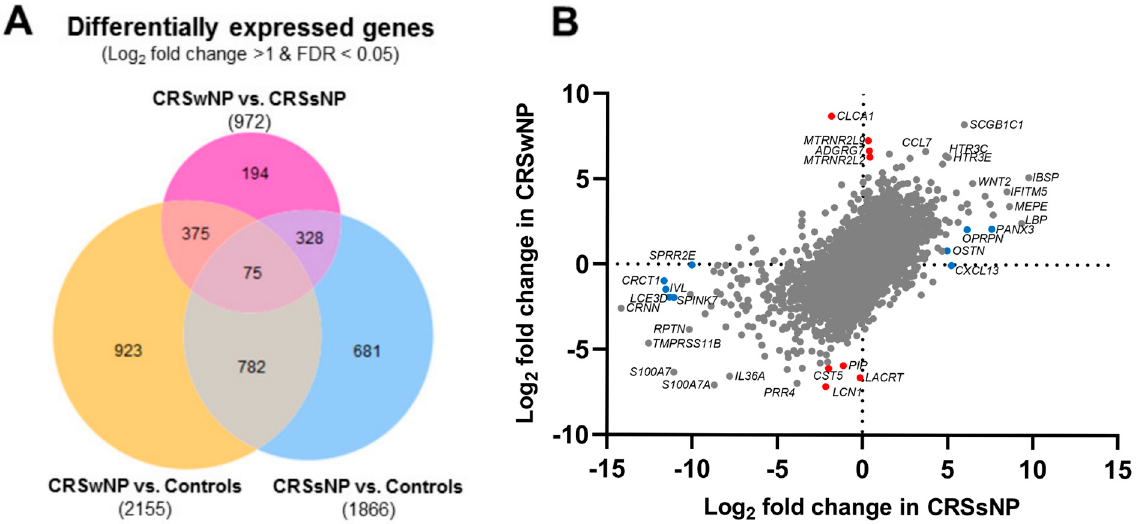
Figure 1. Venn diagram ( A ) and differential gene expression ( B ) in CRSwNP, CRSsNP, and controls. The proposed unique phenotype-associated DEGs with the highest differential expression in one of the phenotypes are presented in red ( ● ) for CRSwNP and blue ( ● ) for CRSsNP.